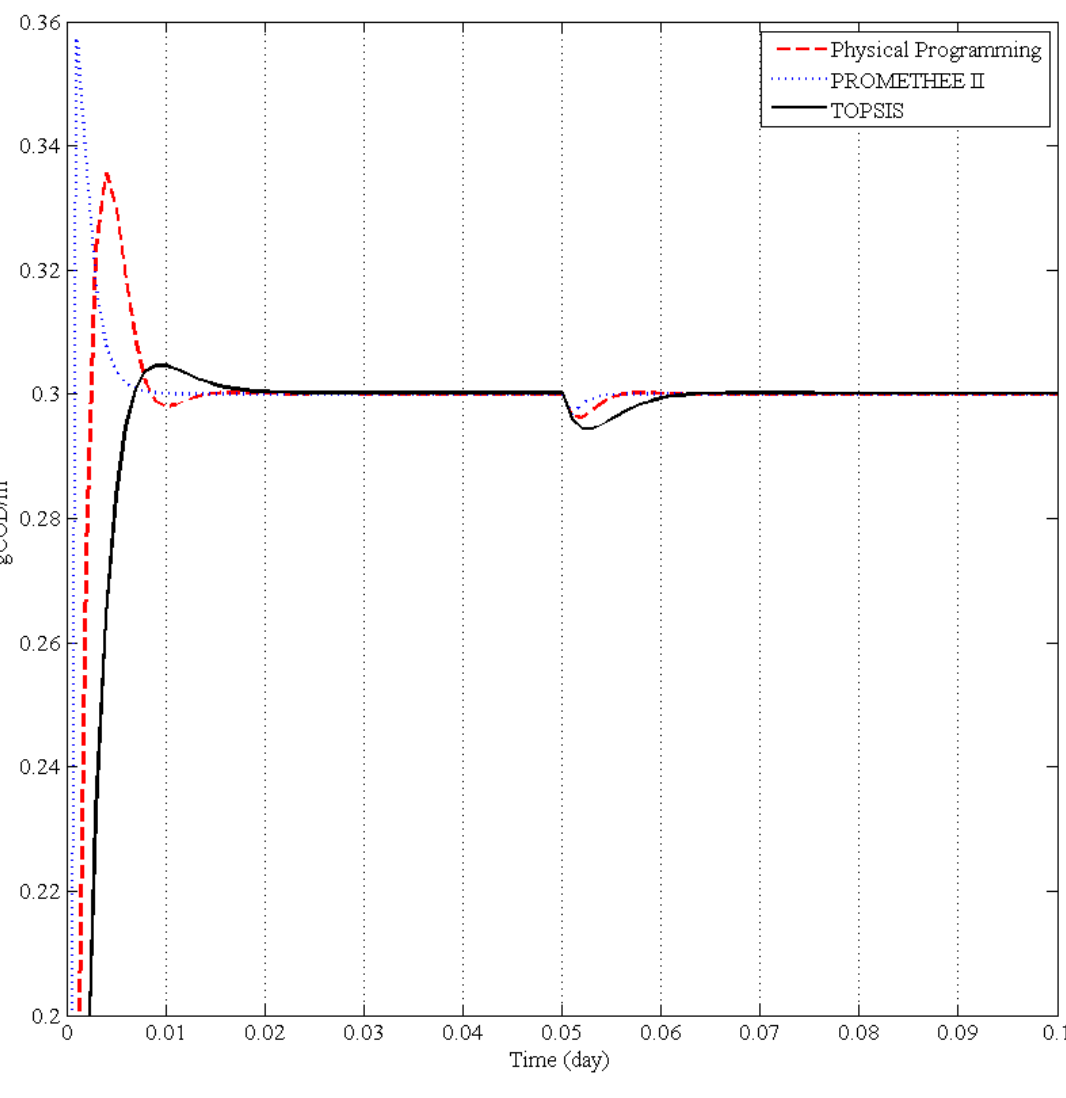
Figure 2. Time response comparison among selected controllers for MOP